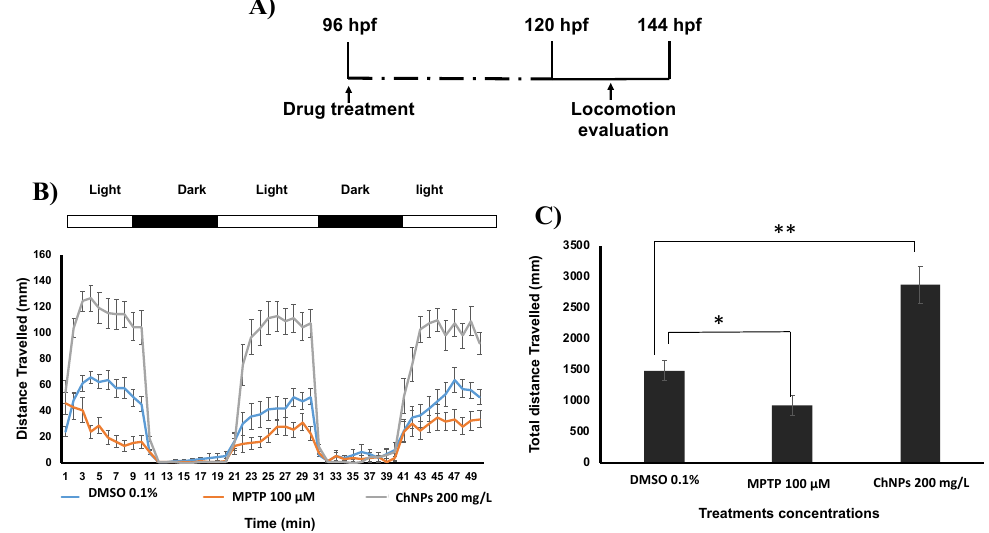
Figure 4. Locomotion assay. ( A ) Scheme of the experimental procedure. ( B ) Average of distance travelled (mm) per min measured by DanioVision. A group of 14 embryos was used for each treatment. ( C ) Average of cumulative distance travelled (mm) by the treated group after exposure to 50 min dark/light cycle. MPTP: 1-Methyl-4-phenyl-1,2,3,6-tetrahydropyridine hydrochloride, positive control for neurotoxicity.